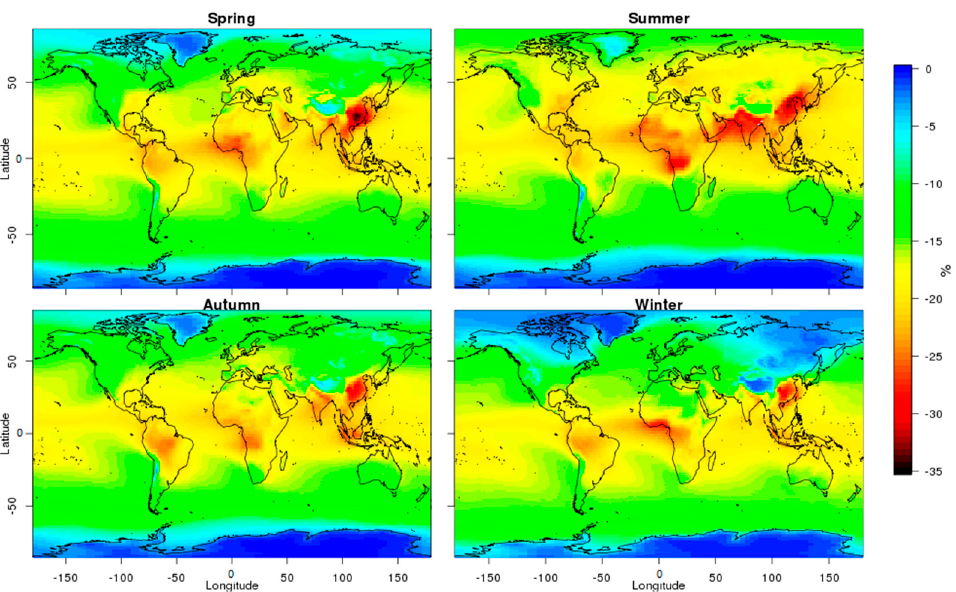
Figure 9. Global spatial distribution of seasonal averaged AOT-PWV effects during the period 2000–2019. AOT-PWV effect is quantified by Equation (1) and refers to the effects on downwelling SW irradiance reaching the Earth’s surface under different values of AOT and PWV.